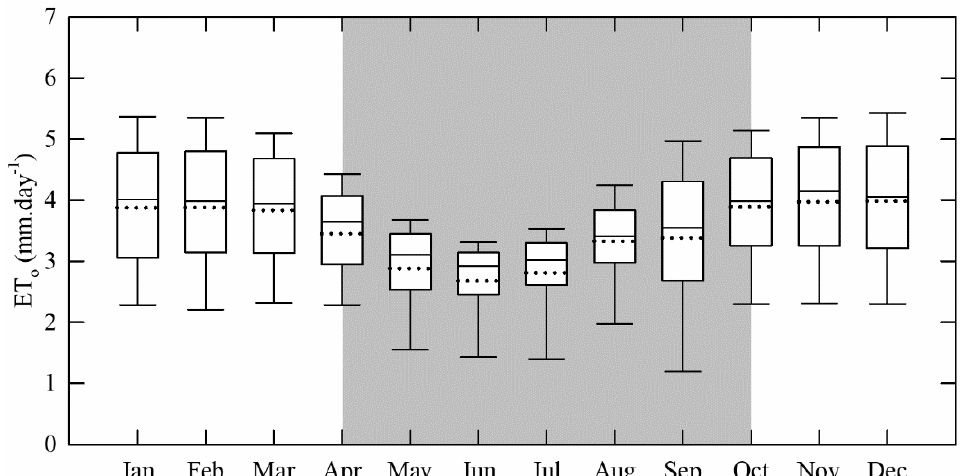
Figure 3. Boxplots showing daily ET o calculations for the Fazenda Miranda site. Each box lies between the second and third quartile, the central line is the median, and the dotted line is the monthly mean. The whiskers indicate the range of data within the minimum and maximum values. The shadowed area indicates the dry season.